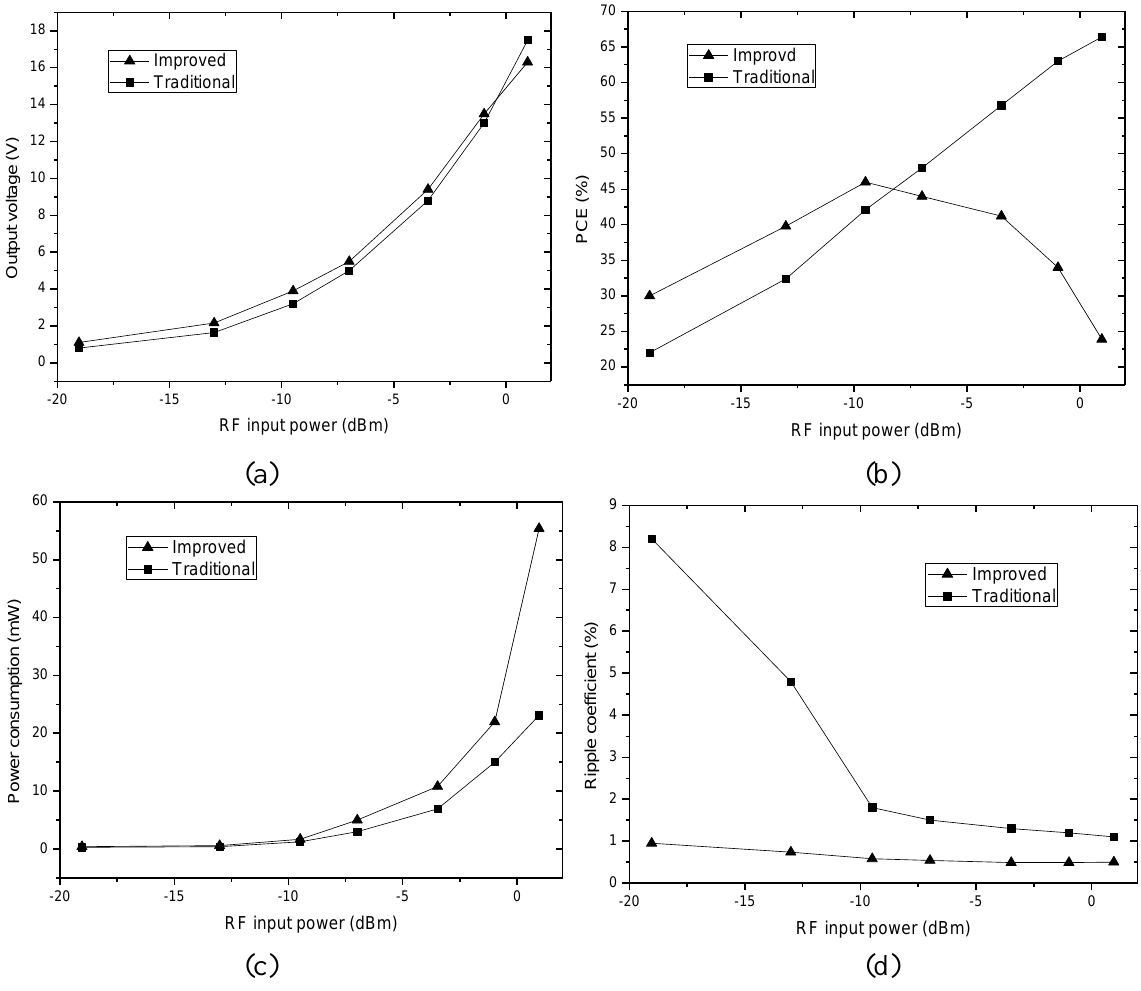
Figure 12. The curves of output voltage, PCE, power consumption and ripple coefficient with different the input power (a) Output voltages with different input power (b) PCEs with different input power (c) Power consumption with different input power (d) Ripple coefficients with different input